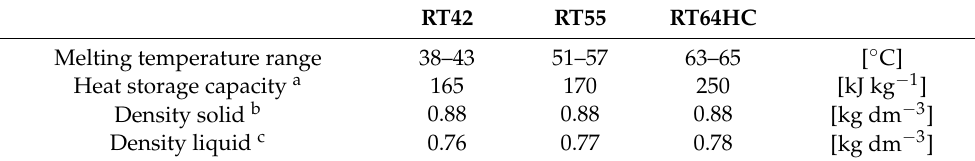
Table 1. Thermophysical characteristics of the tested paraffins. Data by the manufacturer [25]. RT42 RT55 RT64HC Melting temperature range 38–43 51–57 63–65 [ ◦ C] Heat storage capacity a 165 170 250 [kJ kg − 1 ] Density solid b 0.88 0.88 0.88 [kg dm − 3 ] Density liquid c 0.76 0.77